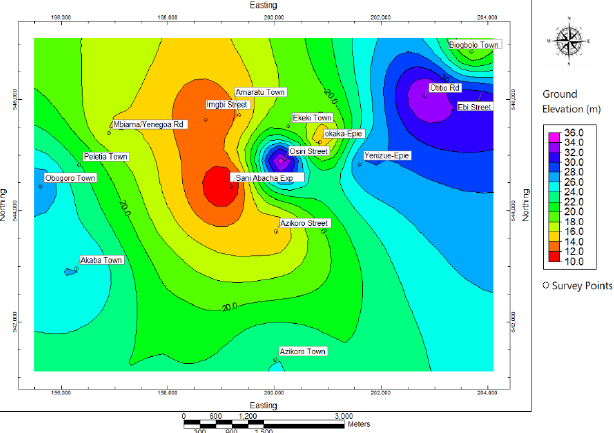
Figure 3 : Elevation Map of Study Area